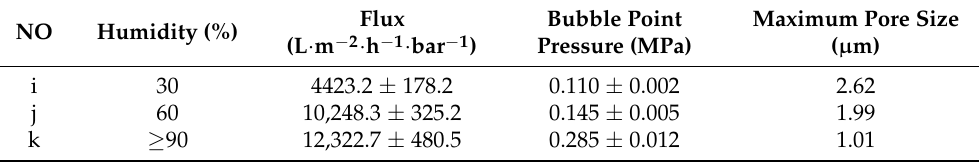
Table 8. The properties of membrane prepared under different ambient